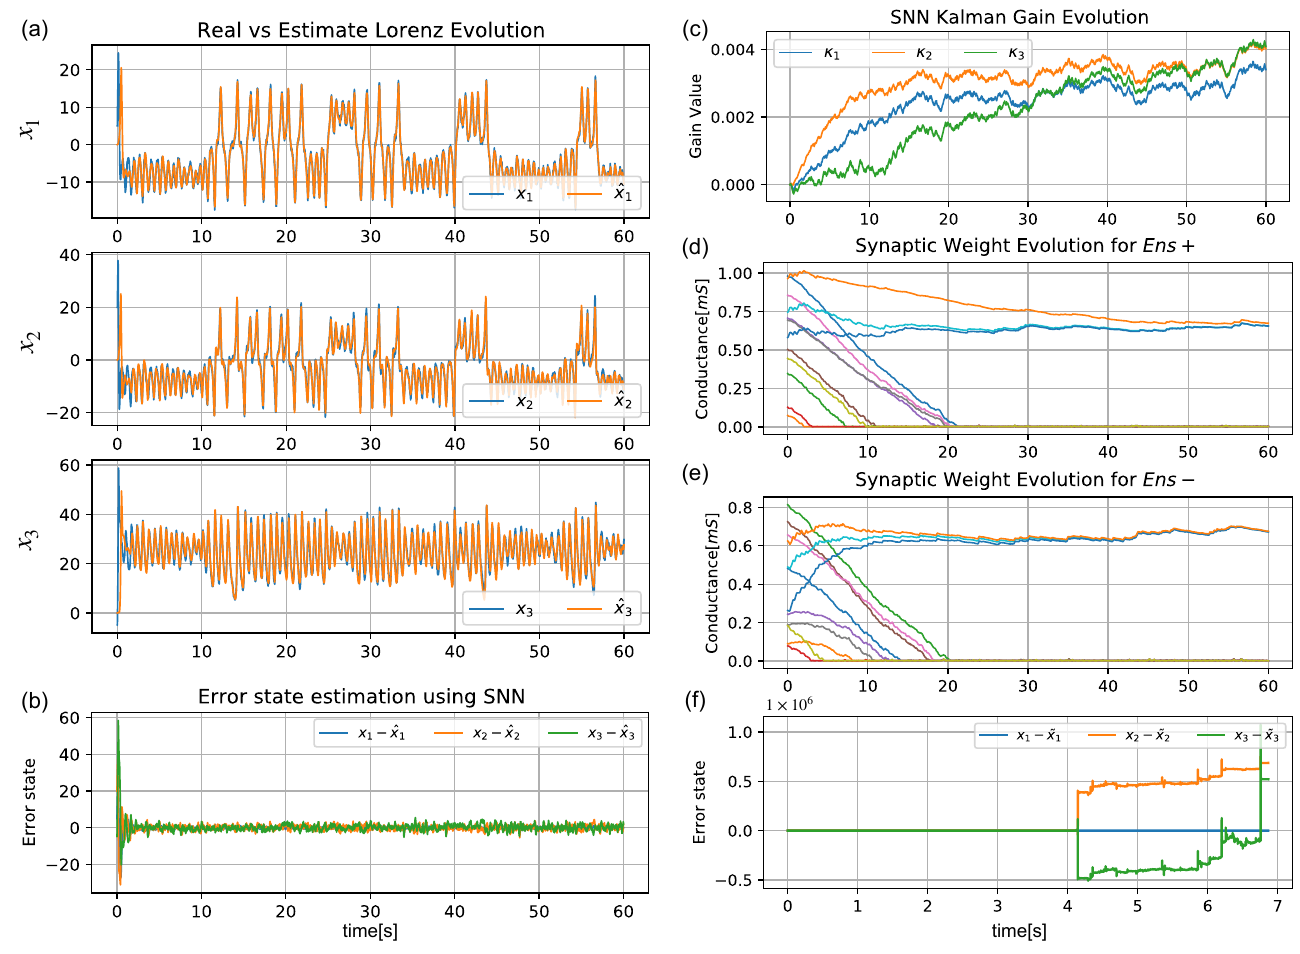
Figure 7. Time evolution of the Lorenz system’s reconstruction when using the proposed architecture in comparison with the ground truth. ( a ) Comparison of the ground truth x (blue) with the recon- struction ˆ x (orange) made by using the proposed SNN architecture. ( b ) Time error reconstruction x − ˆ x of the three states of the Lorenz system. ( c ) Evolution of each value of the Kalman gain matrix. ( d , e ) Weight value evolution over time of the 4 × 3 synapse set (multiple colors) for Ens + and Ens − , respectively. ( f ) Time estimation of the Lorenz system using the standard discrete EKF algorithm without knowledge of the covariance matrices Q , R